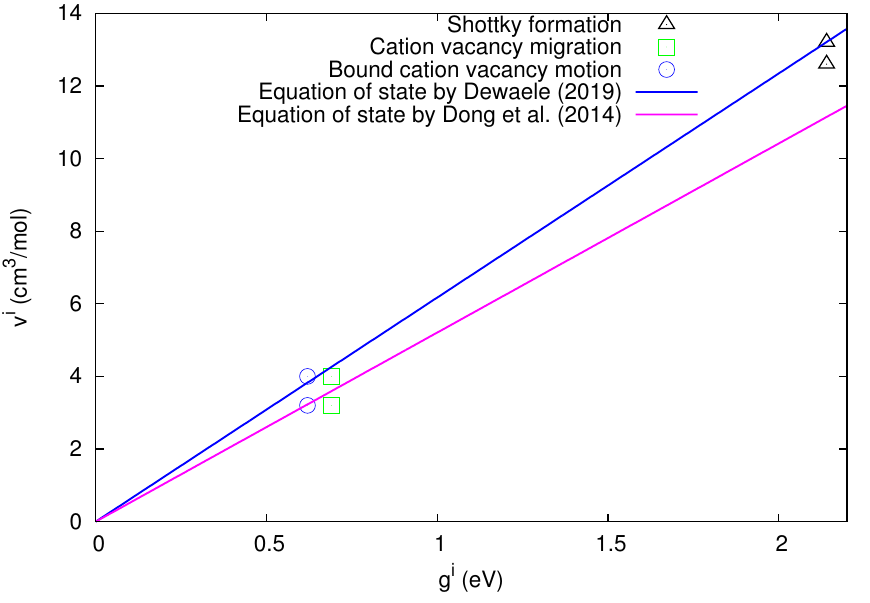
Figure 2. The experimental values of the defect volumes v i in LiF versus the defect Gibbs energy g i for all three defect processes mentioned in the inset. Concerning the blue straight line and the magenta line, see the inset as well as the